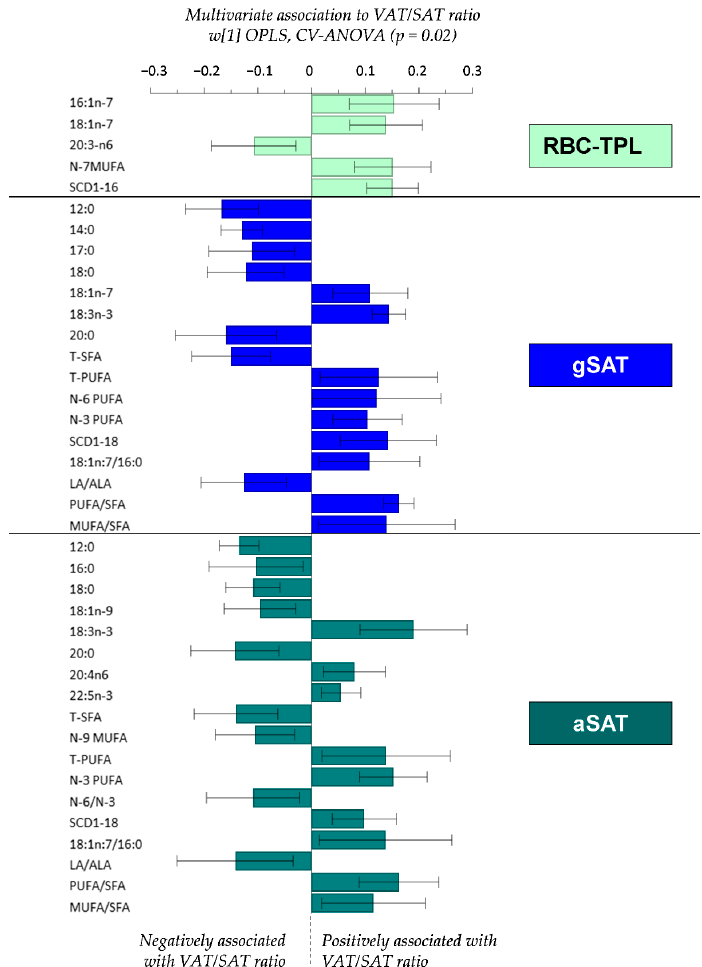
Figure 1. Multivariate OPLS associations between tissue-specific fatty acid composition and the VAT / SAT ratio. Only the individual and grouped FA and FA ratios in each tissue type that were significantly (95% confidence level) associated with the VAT / SAT ratio are shown in the figure. All fatty acids shown in Table 3 were included in the OPLS model. Total saturated fatty acid (T-SFA); total monounsaturated fatty acid (T-MUFA); total polyunsaturated fatty acid (T-PUFA); linoleic acid (LA); alpha-linolenic acid (ALA); stearoyl-CoA desaturase-1 index (SCD1-16: 16:1n-7 / 16:0; SCD1-18: 18:1n-9 / 18:0); 18:1n-7 / 16:0: vaccenic acid (elongation product of 16:1n7) / palmitic acid; gluteal subcutaneous adipose tissue (gSAT); abdominal subcutaneous adipose tissue